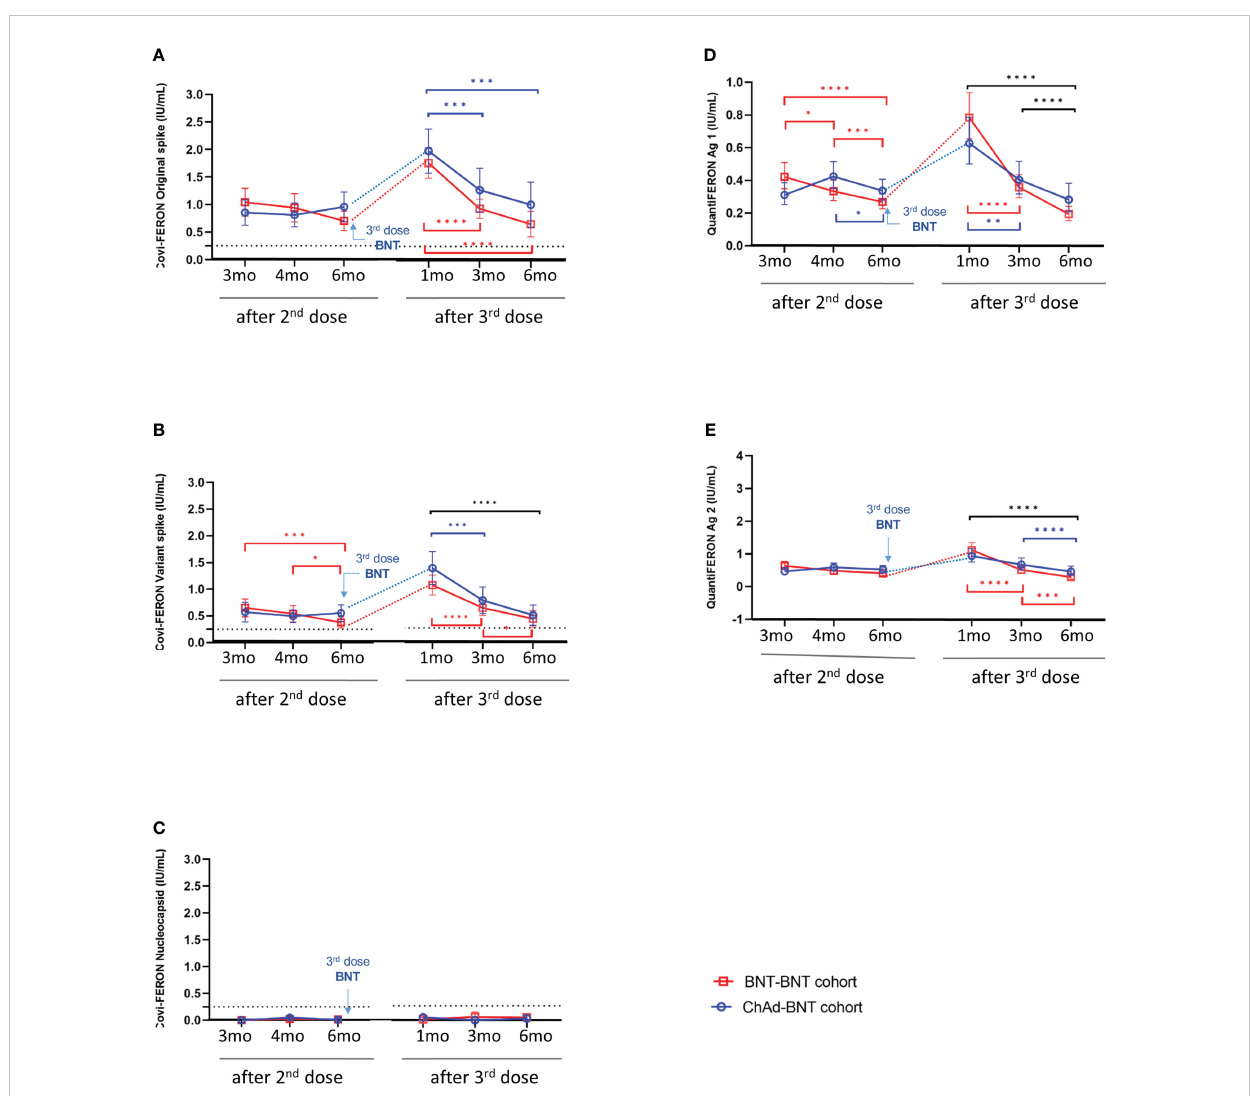
FIGURE 3 Changes in cellular immune responses in infection-naïve participants. SARS-CoV-2-speci fi c T cell responses were measured by ELISA targeting various antigens produced by two different manufacturers (A) Covi-FERON stimulating original spike protein, (B) Covi-FERON variant spike protein, (C) Covi- FERON nucleocapsid protein, (D) QuantiFERON antigen 1 and (E) QuantiFERON antigen 2). Results from Covi-FERON are presented as mean with 95% con fi dence interval, and data measured by QuantiFERON are presented as geometric mean with a 95% con fi dence interval. The statistical signi fi cance was calculated using repeated measure two-way ANOVA with Sidak ’ s multiple comparisons test. When the ChAd-BNT cohort and BNT-BNT cohort revealed signi fi cant differences between groups, the signi fi cance was expressed either over the blue circle or over the red square. When signi fi cant change was observed over a certain period, it was expressed using ticked lines (blue: Chad-BNT cohort, red: BNT-BNT cohort, and black: both cohorts). The assay cut-off is presented as a horizontal dotted line. * P <0.05; ** P <0.01; *** P <0.001; **** P <